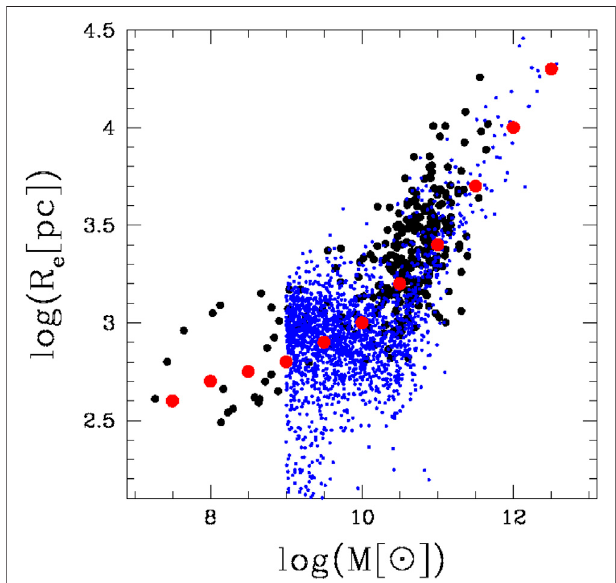
FIGURE 3 | The MR plane. The black dots mark the observational data of the WINGS survey. The blue dots are the Illustris data of the TNG release shifted by a constant value in log( R e ) of − 0.45 (simulations still provide systematically larger radii). The red dots mark the values of R e obtained from Eq. 2 (see the